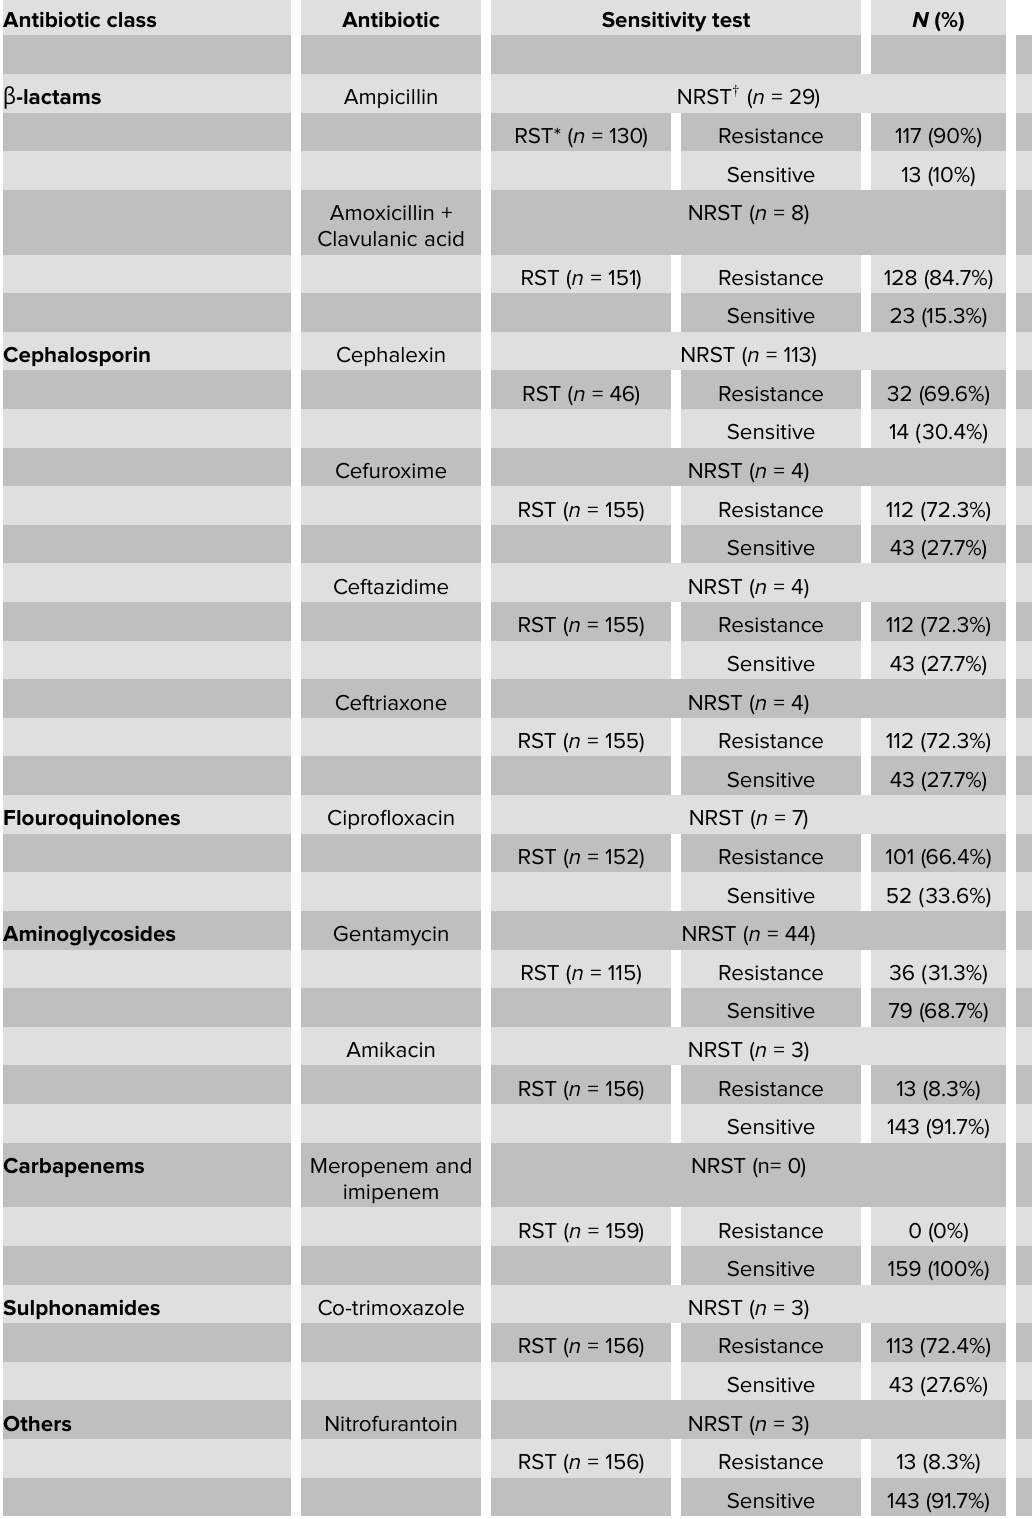
Table 4: Distribution of adult patients’ sample according to sensitivity pattern ( n =